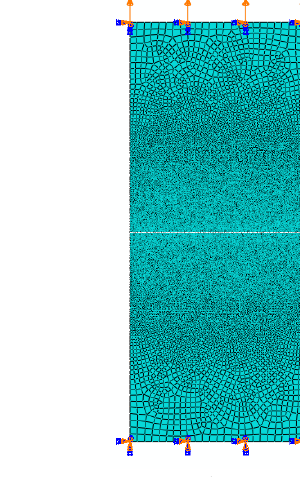
Table 2. Mechanical properties of the laminate.